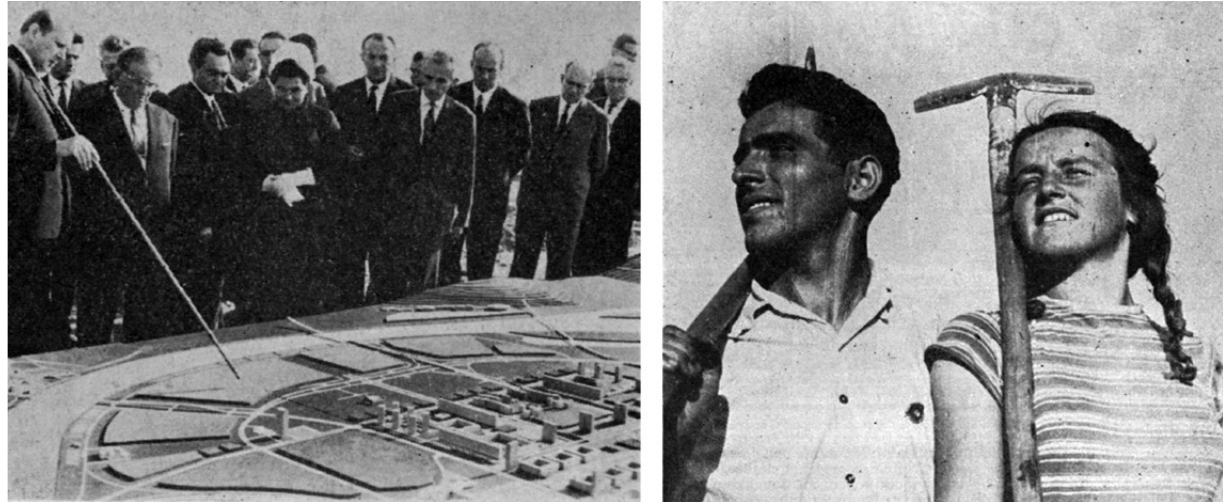
Figure 3. Planning New Belgrade (left) and constructing New Belgrade: The first construction workers in 1948—Yugoslav youth (right). Source: Stefanovic (1969, pp. 47–48).